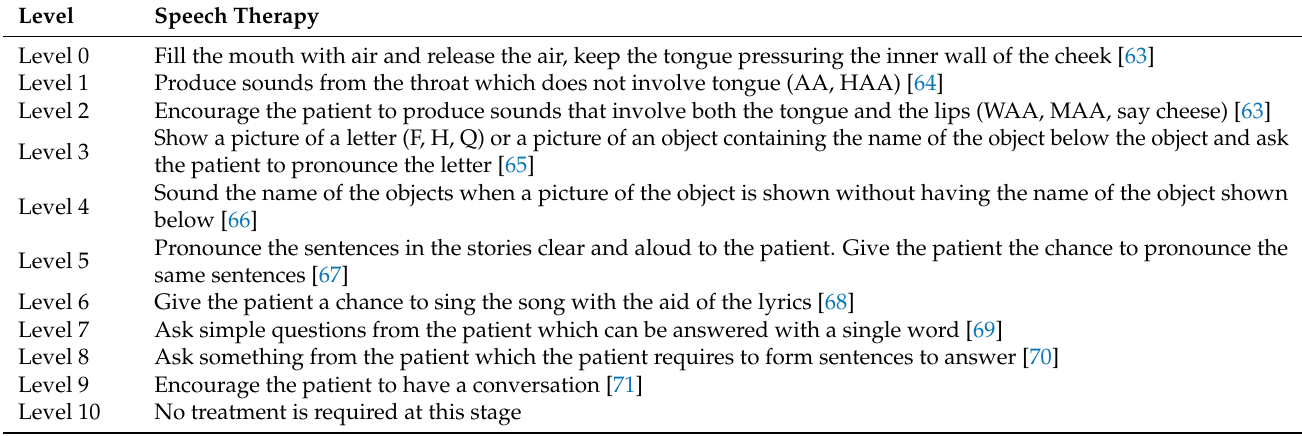
Table 3. Mapping of aphasia severity levels to speech